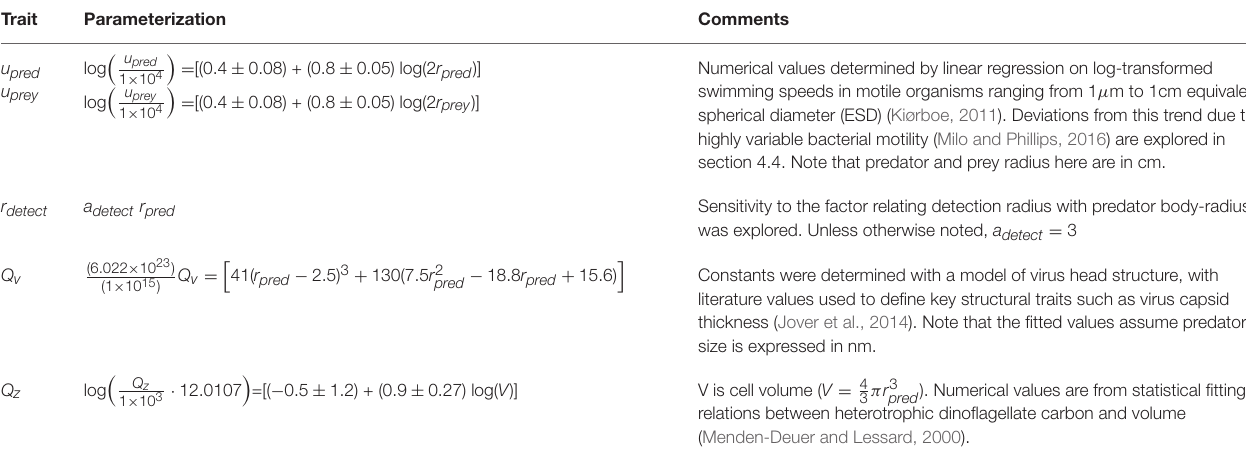
TABLE 2 | Size dependent trait parameterizations for individual predators and prey.